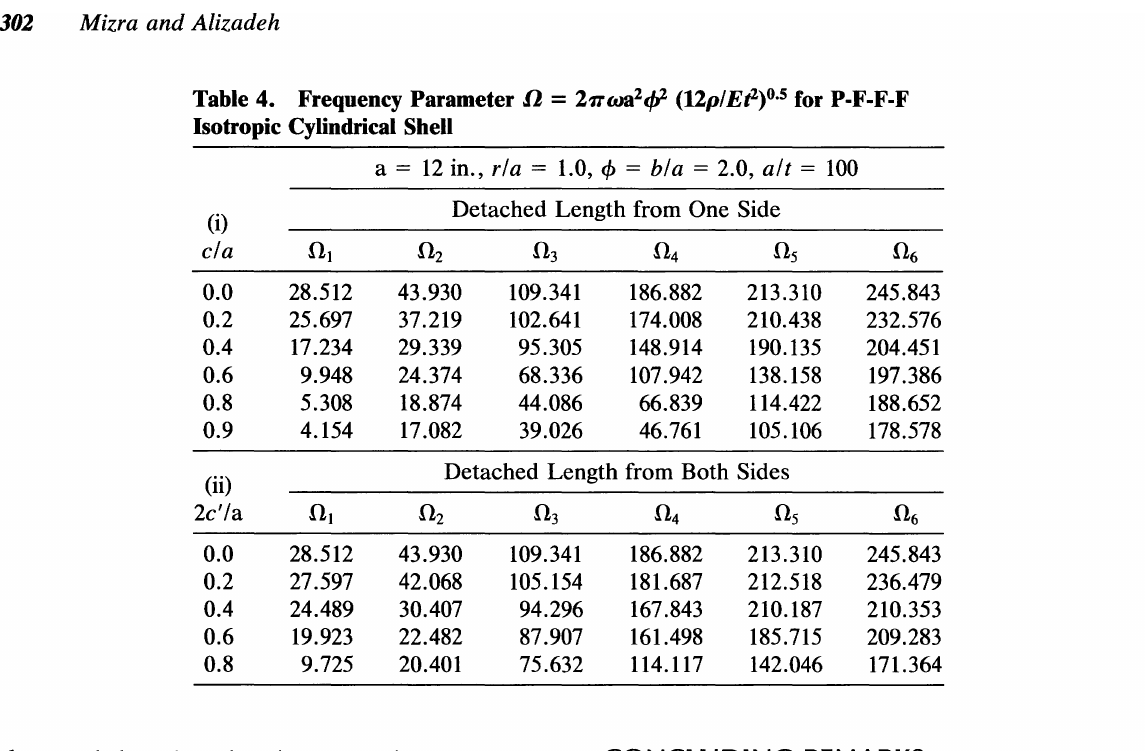
Table 4. Frequency Parameter Isotropic Cylindrical Shell